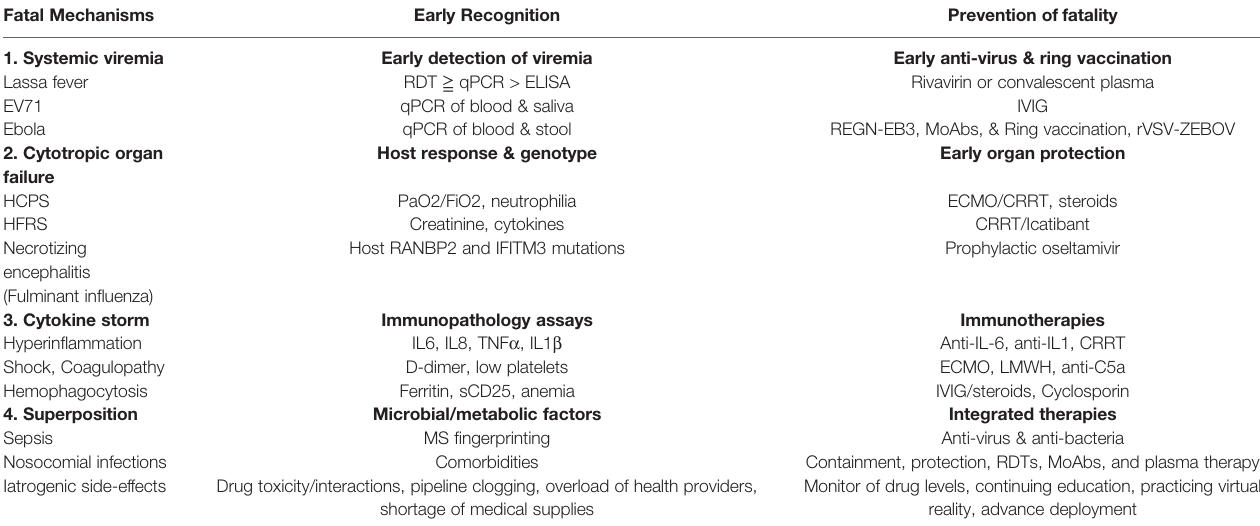
TABLE 3 | Early recognition of fatal mechanism for prevention of